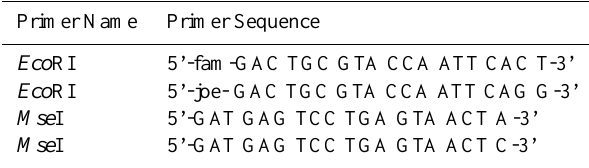
Table 2. Primers used in the study (Applied